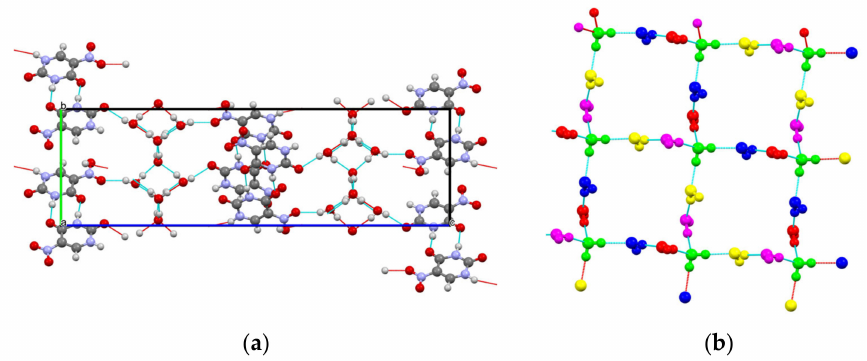
Figure 15. ( a ) Crystal packing in (XIV) , showing dimers with the M2 motif, DIABCO molecules were omitted for clarity. ( b ) Detail of water molecules framework.